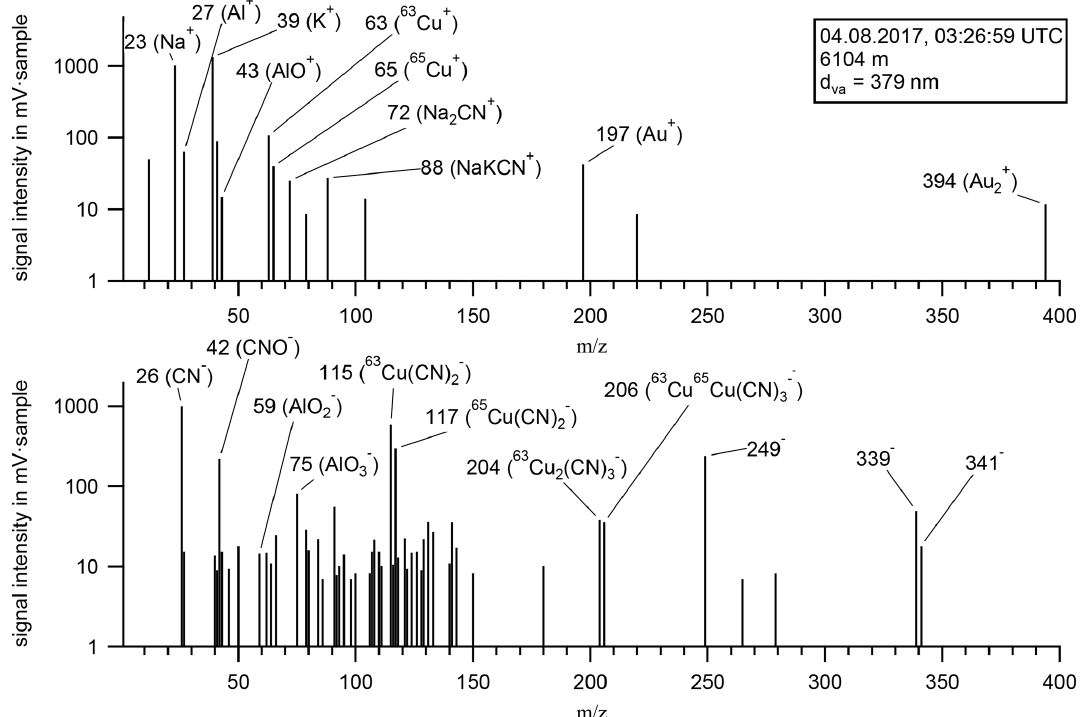
Figure 9. Bipolar spectrum from a single particle sampled at a barometric altitude of 6104m during the KTM 5 flight from Kathmandu, Nepal, on 4 August 2017 indicating gold contamination. Only signals above the ion area peak threshold (7mV per sample; Hünig et al., 2022) are